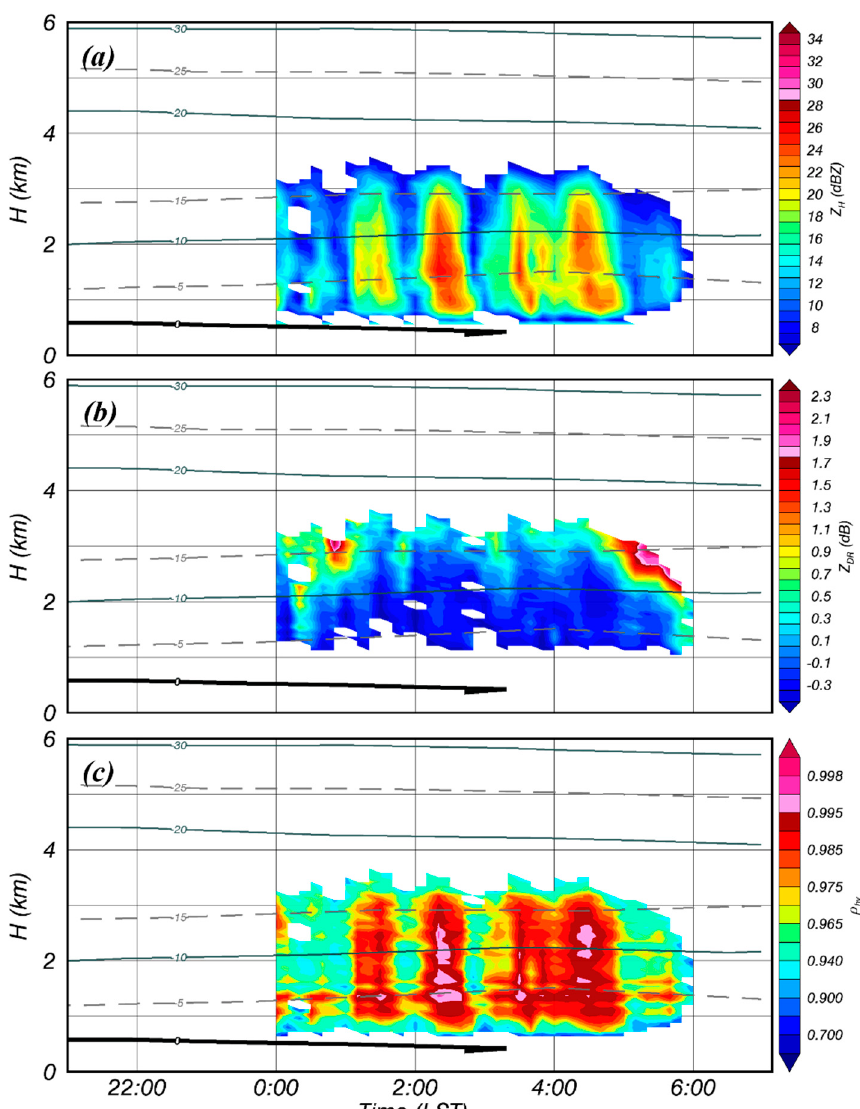
Figure 10. Time series of the QVP of the dual-pol radar variables for C1 (27 February 2016): ( a ) Z, ( b ) Z DR , and ( c ) ρ HV . The lines in the background of the figure are the vertical temperature profiles obtained using the MSM reanalysis data.